Question: Briefly state, in one sentence, what is plotted here.
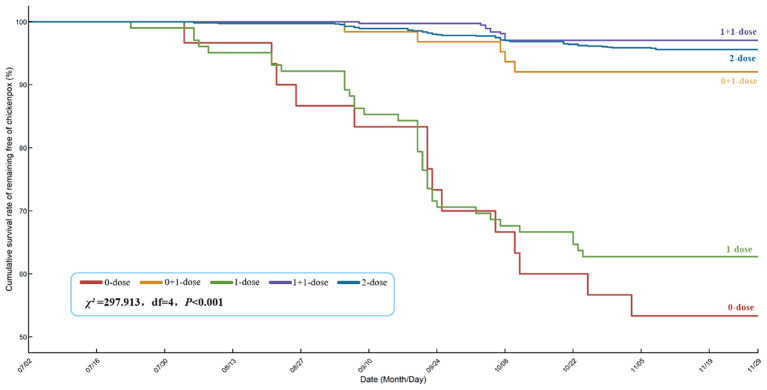
Answer: Survival curves for varicella among students with different immunization histories. The 0 + 1-dose group refers to students who had not received varicella vaccine before the outbreak and received one dose during the outbreak; the 1 + 1-dose group refers to students who had received one dose before the outbreak and received one additional dose during the outbreak.